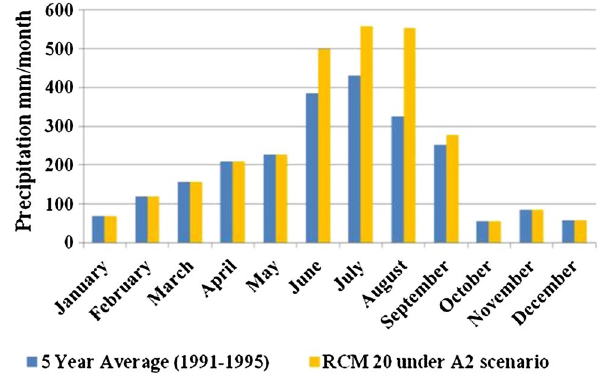
Fig. 7 Precipitation change pattern after 100 years